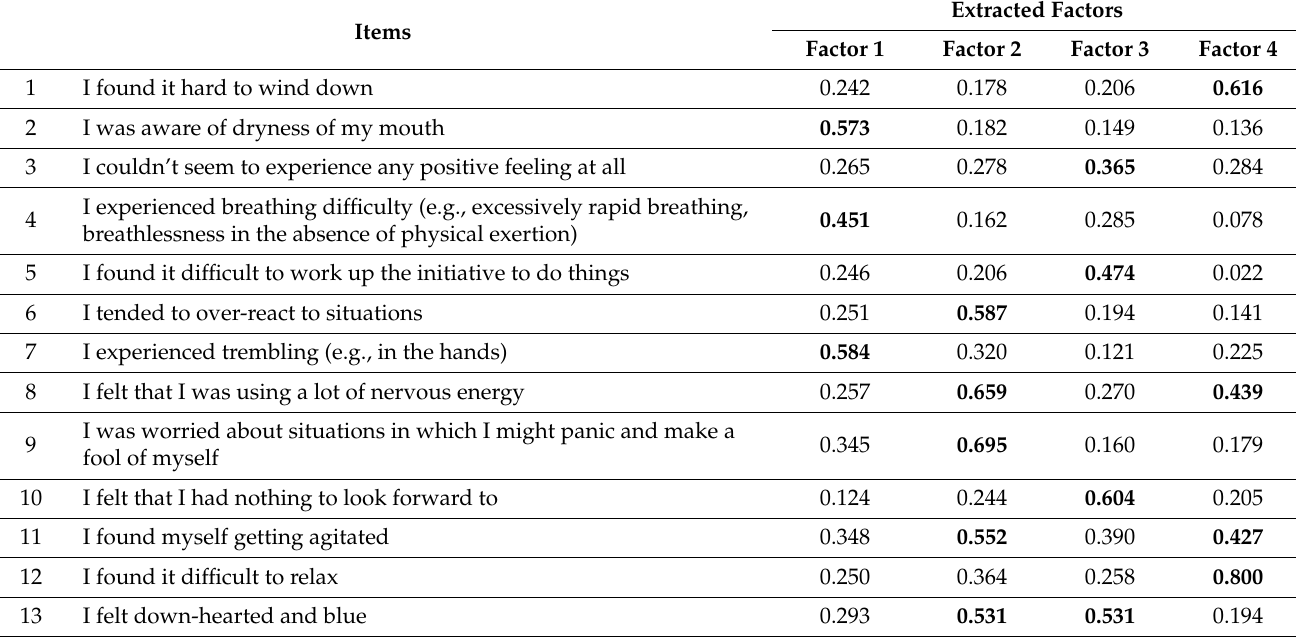
Table 1. Item loadings on corresponding factors as revealed by exploratory factor analysis of the Depression Anxiety Stress Scale 21 (DASS-21) in the quarantine